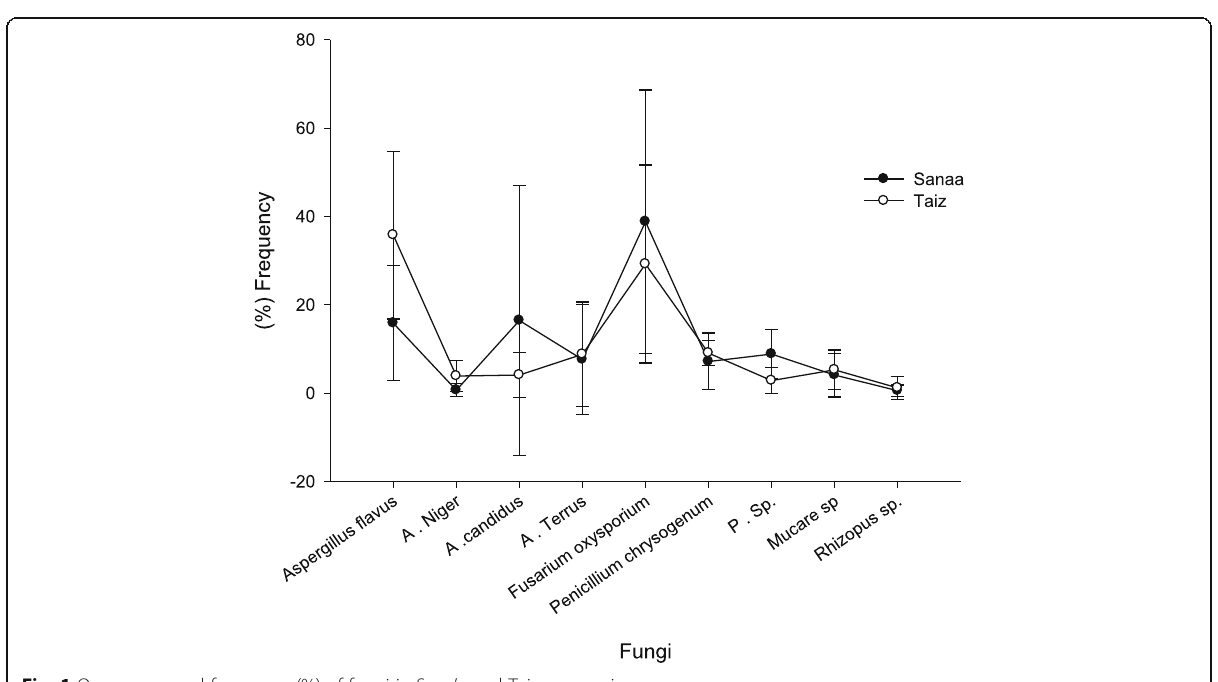
Fig. 1 Occurrence and frequency (%) of fungi in Sana ’ a and Taiz companies